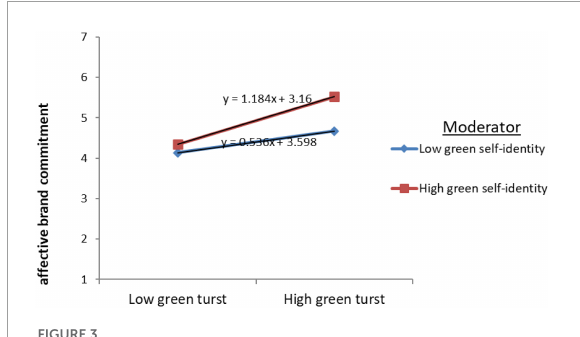
FIGURE3 The moderating effect of green self-identity on green trust and affective